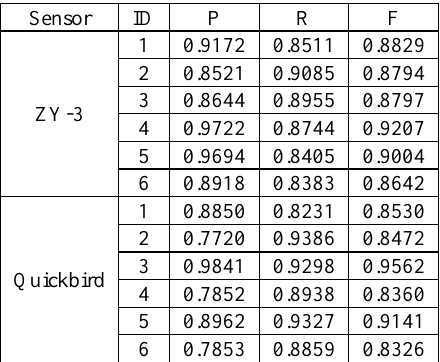
Table 1. Accuracy evaluation results for the test